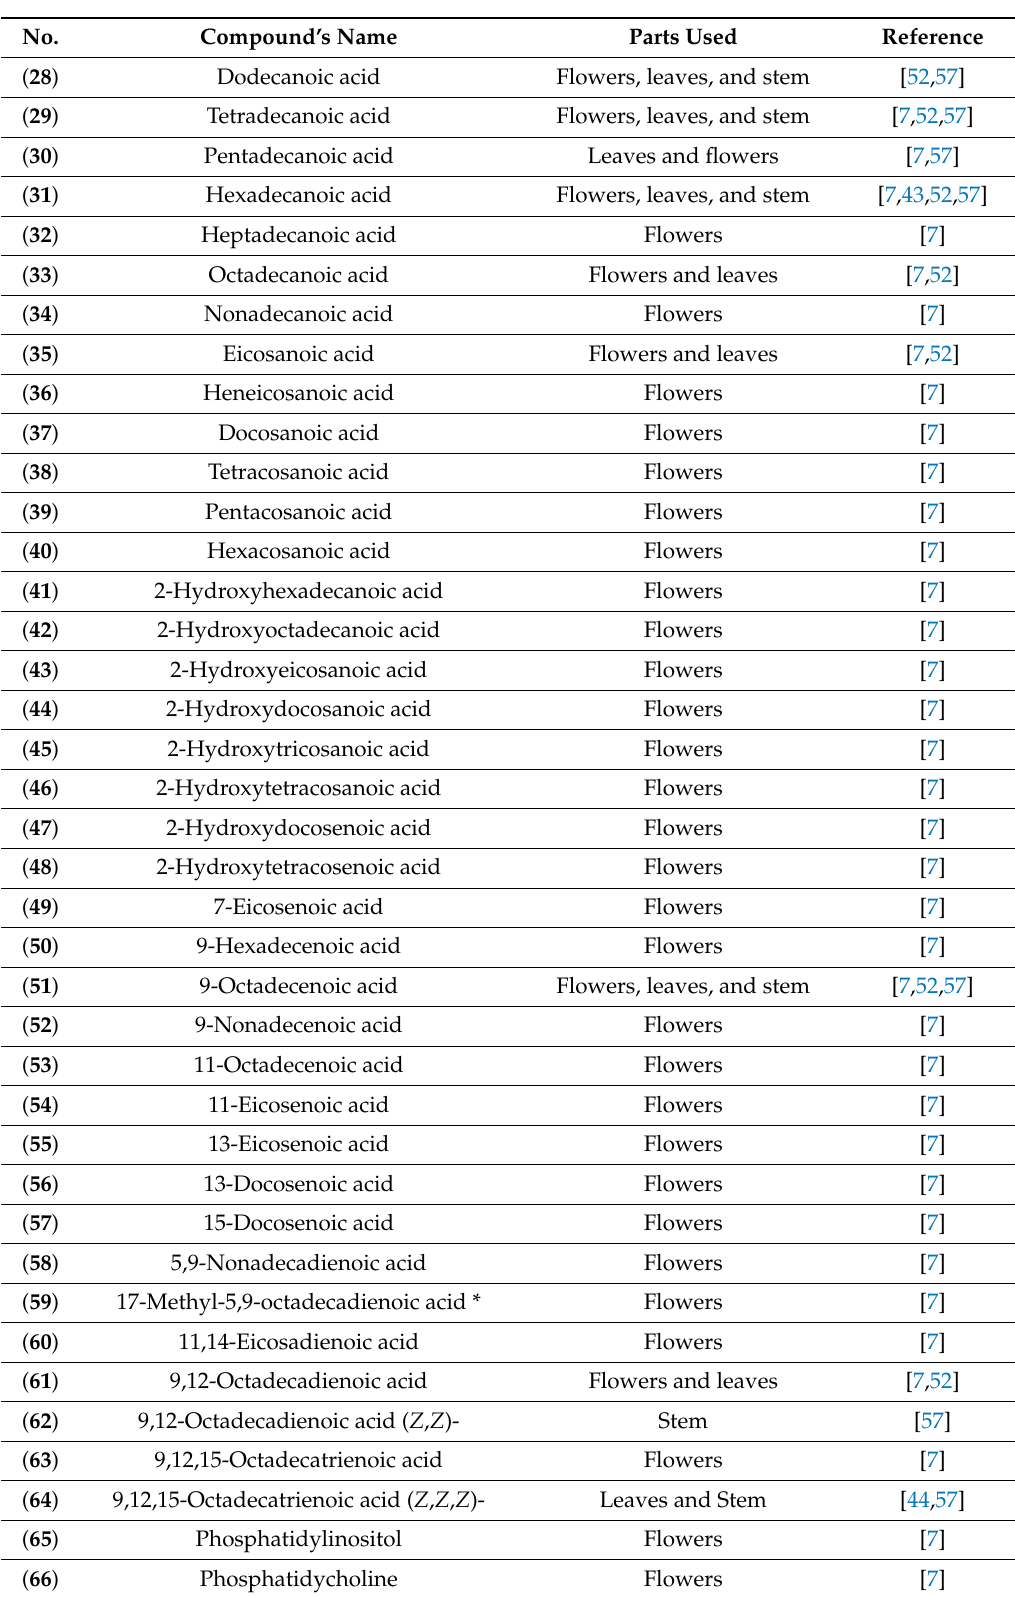
Table 3. The fatty acids and phospholipids from A. cathartica